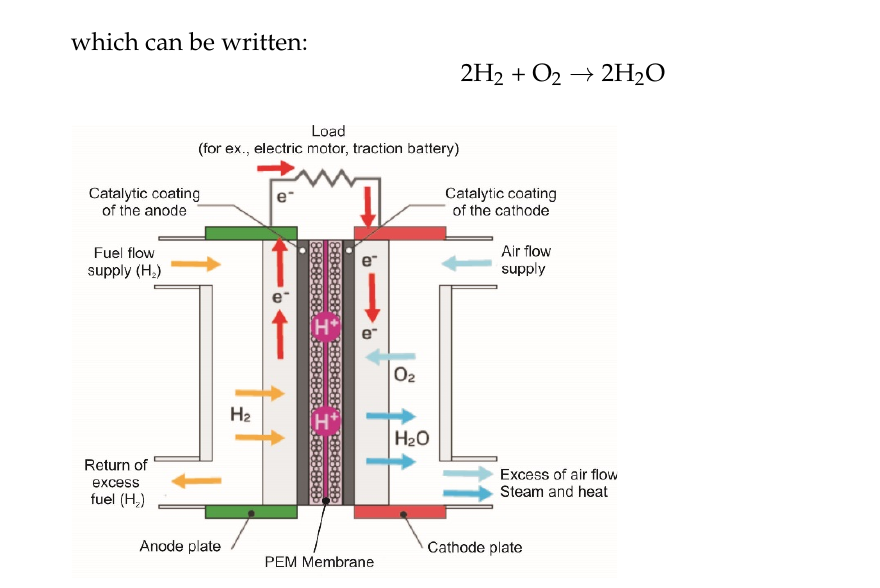
Figure 5. A functional diagram of a fuel cell of PEM type [13].